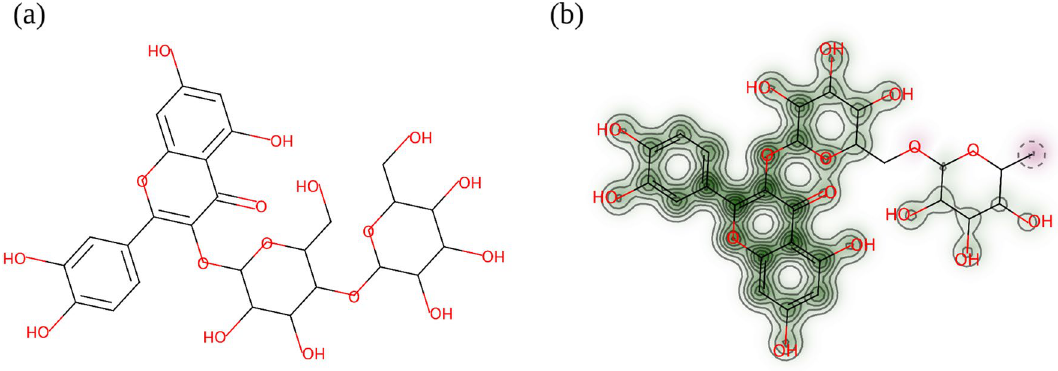
Figure 4. Similarity map for ECFP fingerprint with a default radius of 2 ( a ) structure of reference molecule Q3M from the DrugAge database ( b ) similarity map of rutin. In green colour are bits that if removed will decrease the similarity, whereas removing bits represented in pink colour will increase the similarity between the two compounds 38 . The figure was created in the RDKit Python environment 19